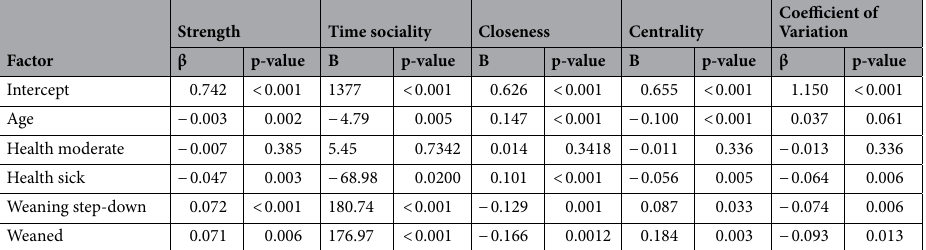
Table 2. Effects of age, health status, and weaning status in the different association network measures. The coefficients and p -values are derived from the linear mixed model. In bold are the coefficient with significant